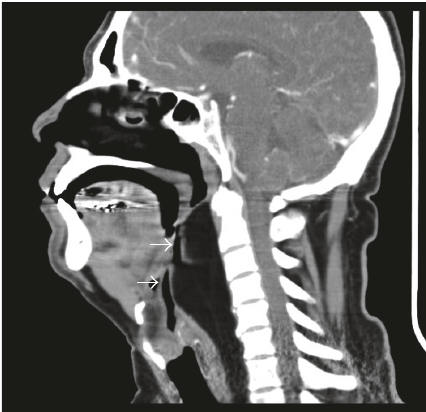
Figure 2: Sagittally reconstructed CT image shows narrowing of the airway (arrows) to a better